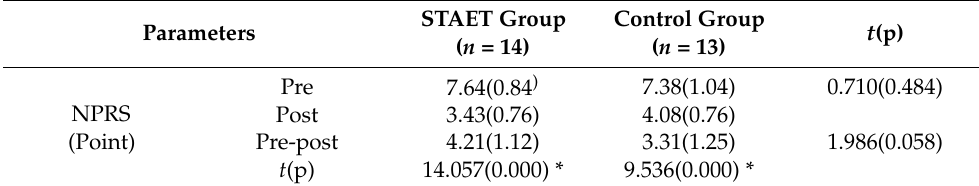
Table 5. Comparison of numeric pain rating scale (N =